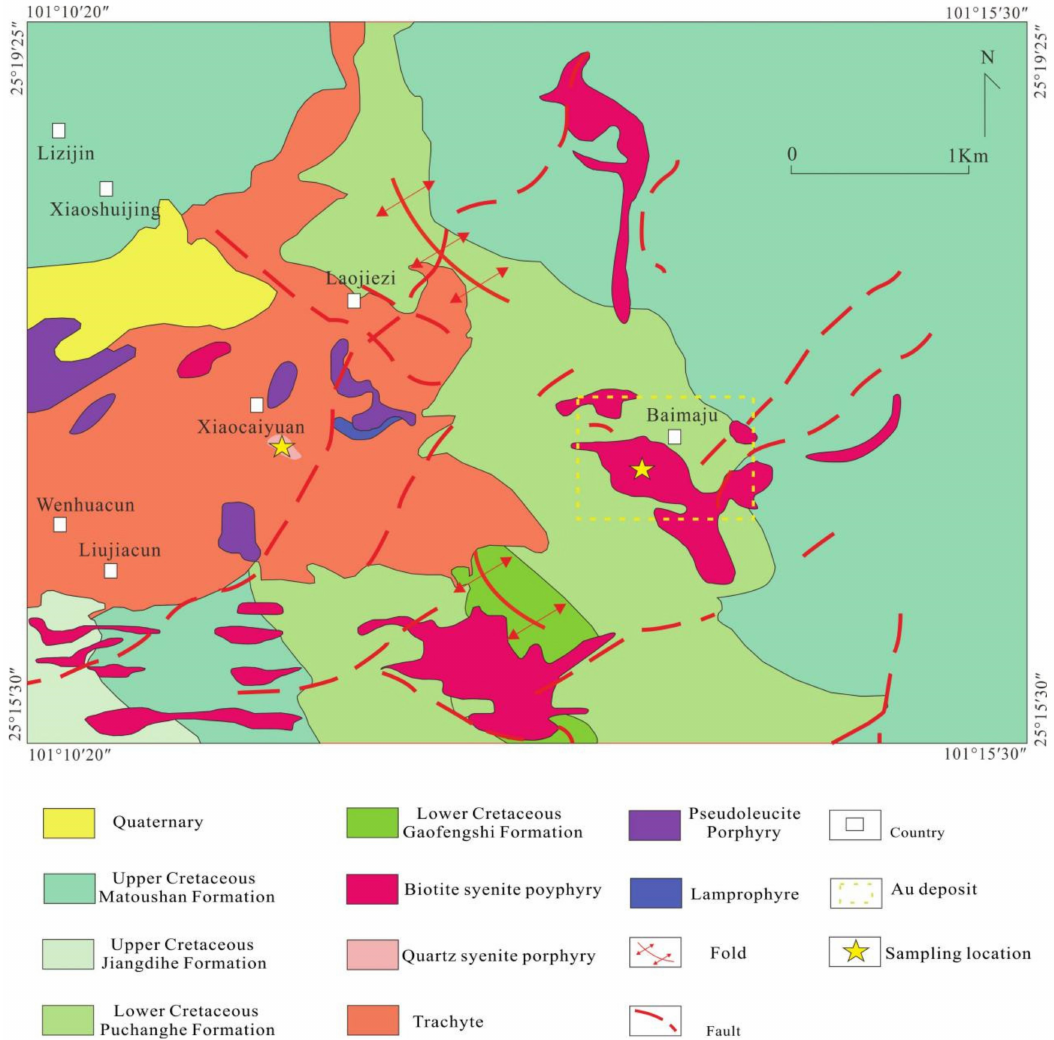
Figure 2. Simplified geological map of the Yao’an gold deposit, showing the distribution of the Yao’an alkaline volcanic- magmatic complex